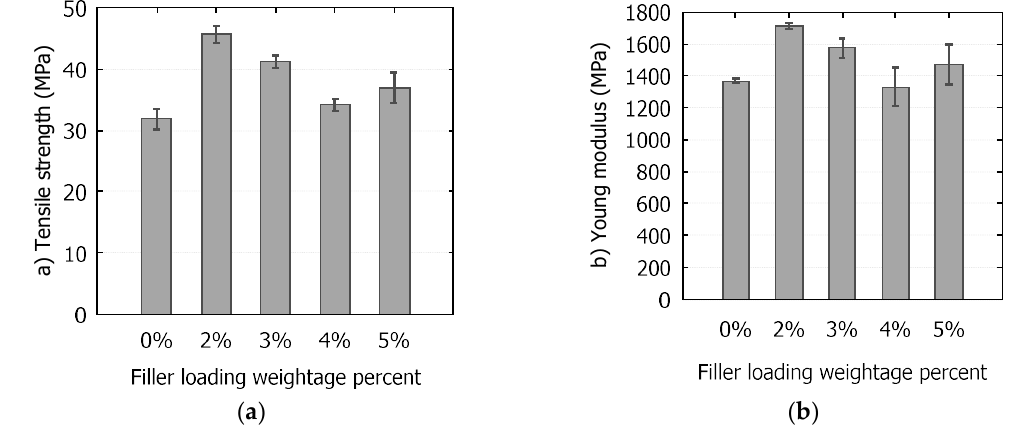
Figure 3. Effect of baggage filler loading on the mechanical properties of composites: ( a ) tensile strength and ( b ) Young’s modulus.